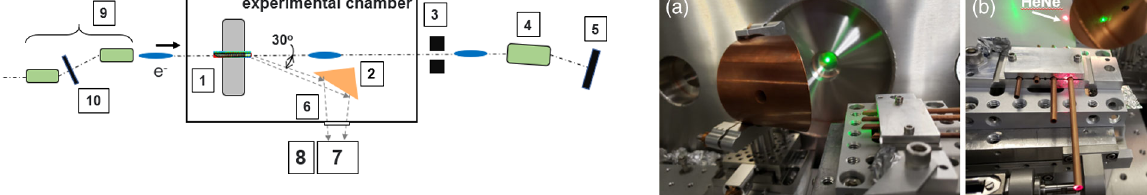
FIG. 12. A setup of the experiment with corrugated wave- guides: (a) side view, (b) front view. See text for details.